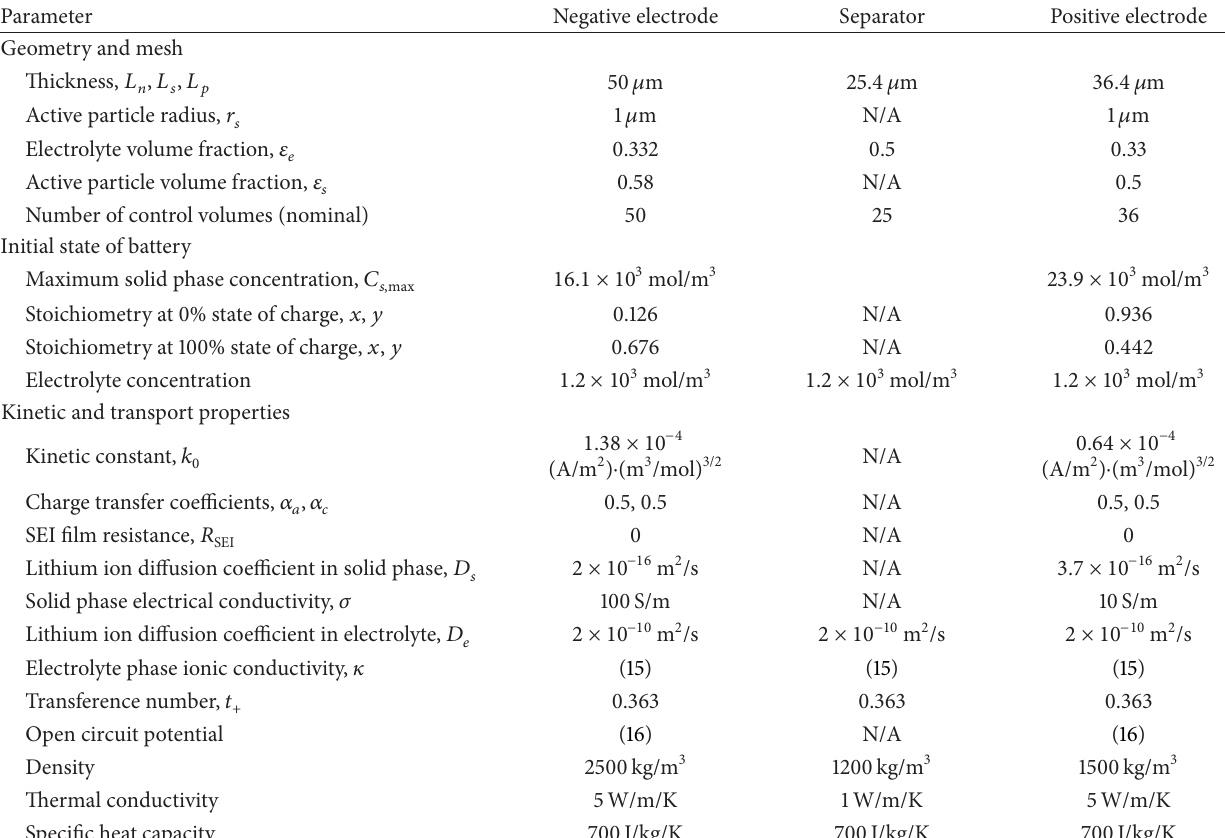
Table 2: Values of various parameters for the Li 𝑥 C 6 -Li 𝑦 Mn 2 O 4 battery simulated in the present